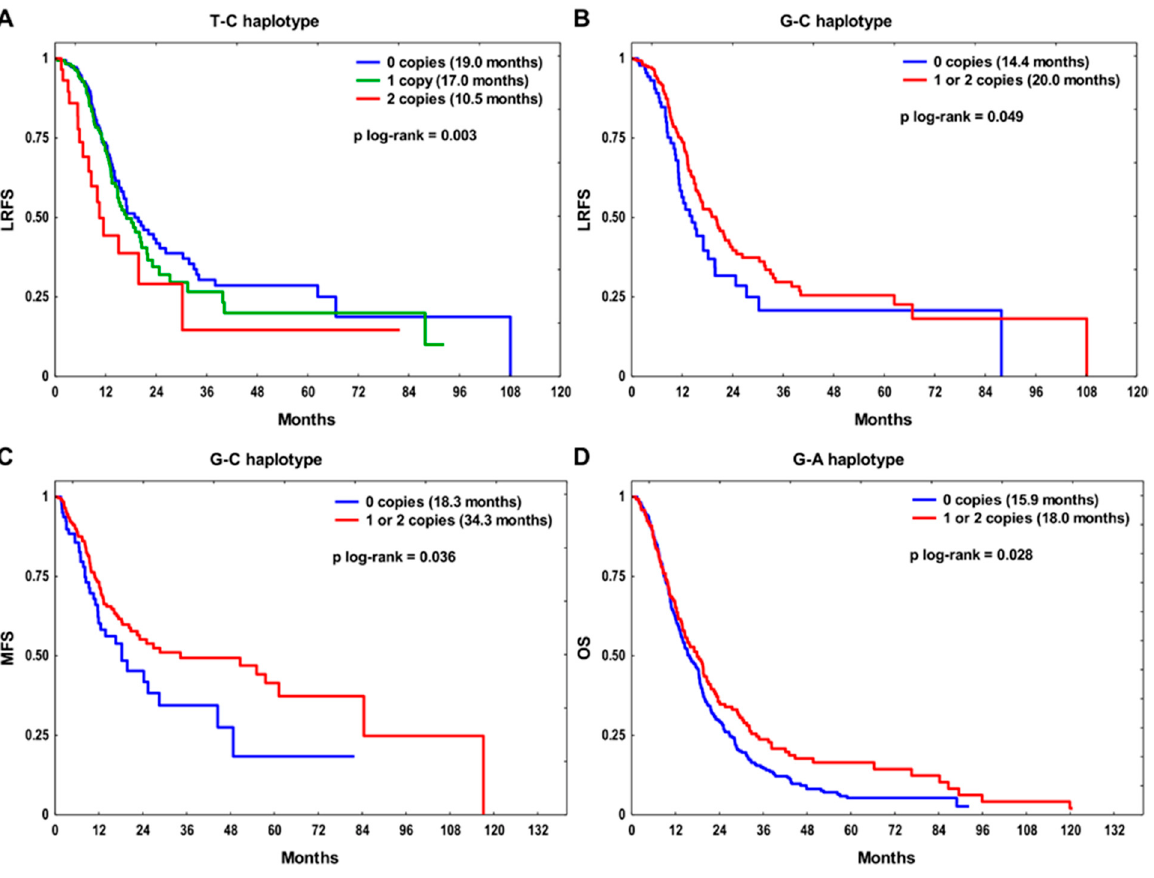
Figure 2. The Kaplan–Meier survival analysis according to the rs712829 and rs712830 haplotypes: ( A ) T-C haplotype and ( B ) G-C haplotype in relation to locoregional recurrence-free survival (LRFS), ( C ) G-C haplotype in relation to metastasis-free survival (MFS), and ( D ) G-A haplotype in relation to overall survival (OS). Median survival time is shown in the brackets.